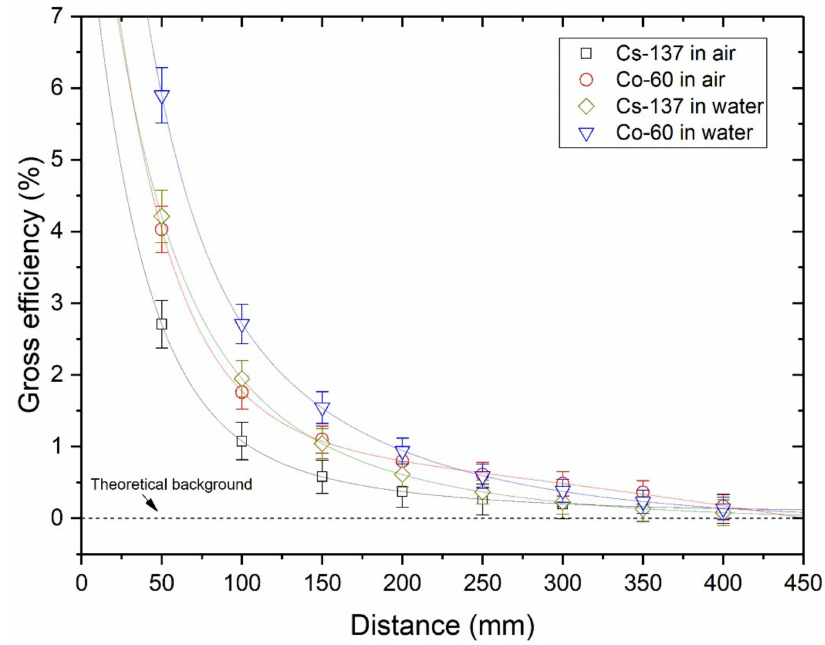
Figure 10. Gross efficiency for sealed sources at different distances and